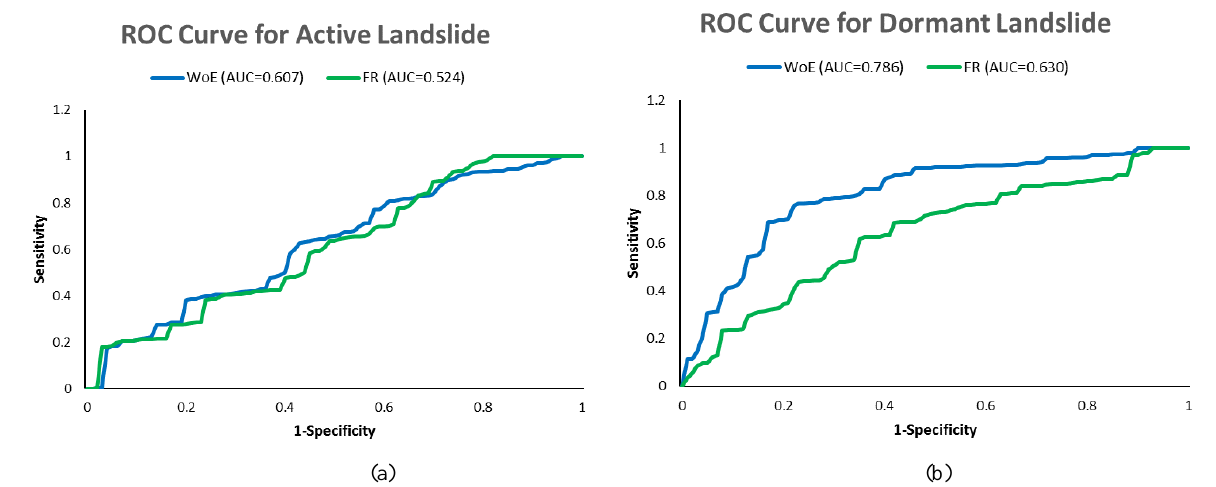
Figure 6. The success rate for (a) active and (b) dormant landslide activities for different methods by ROC curve